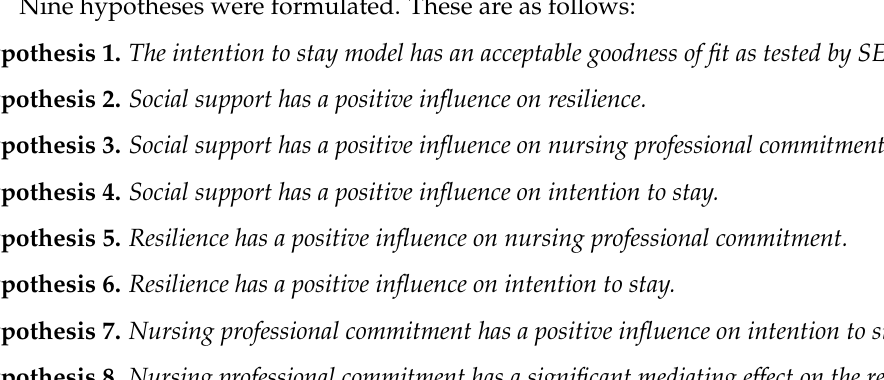
Figure 1. A structural equation model of the factors affecting the intention to stay in nursing of newly graduated male nurses.